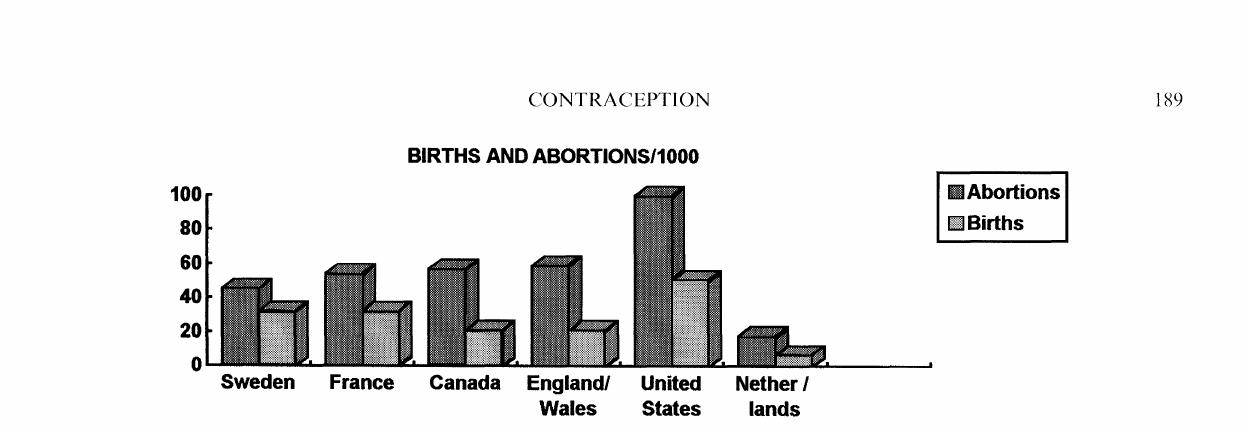
and policy. Faro Plan perspect 1985; 17(2):